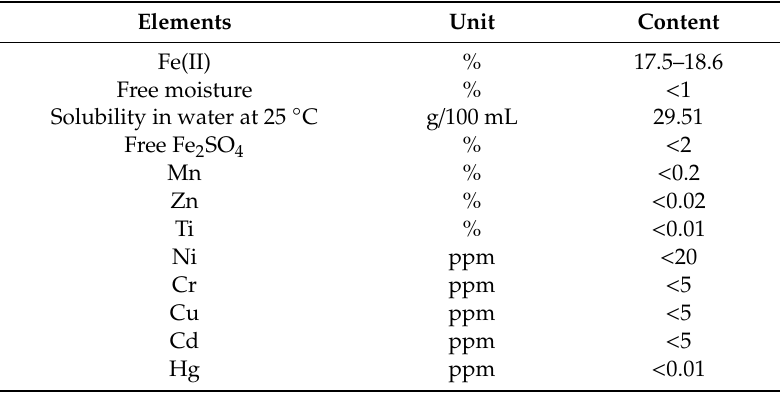
Table 1. Typical analyses of FeSO 4 · H 2 O